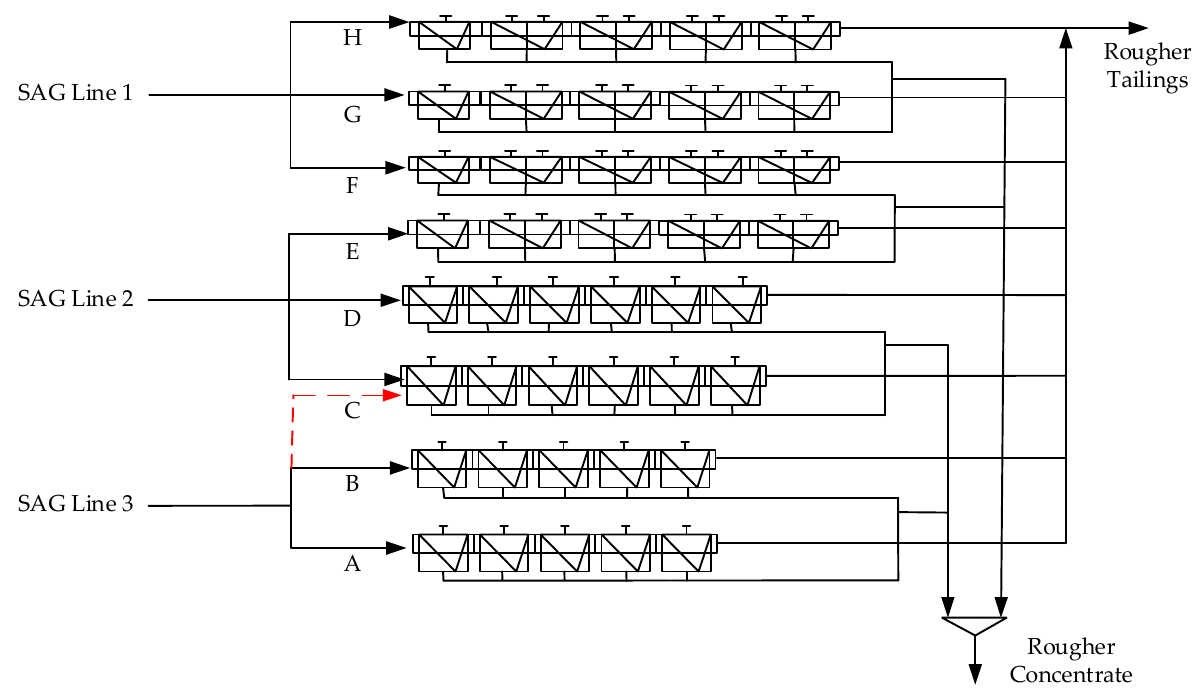
Figure 1. Rougher flotation circuit of Minera Los Pelambres. The dashed line represents an optional stream.